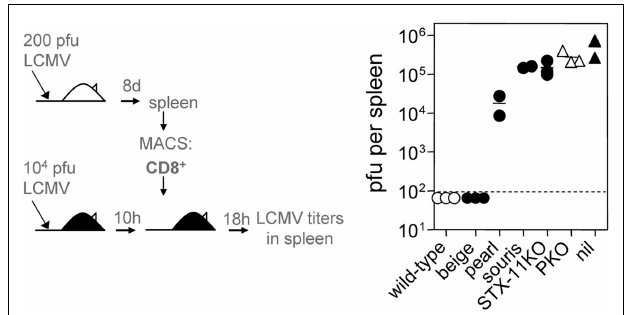
triangle) mice were MACS purified and 2 × 10 6 of MACS purified CD8 + T cells were transferred into wild-type C57BL/6 mice that had been infected with 10 4 pfu LCMV 10h before. After 18h of CD8 + T cell transfer, viral titers in spleen were determined (nil: infected wild-type C57BL/6 without cell transfer).